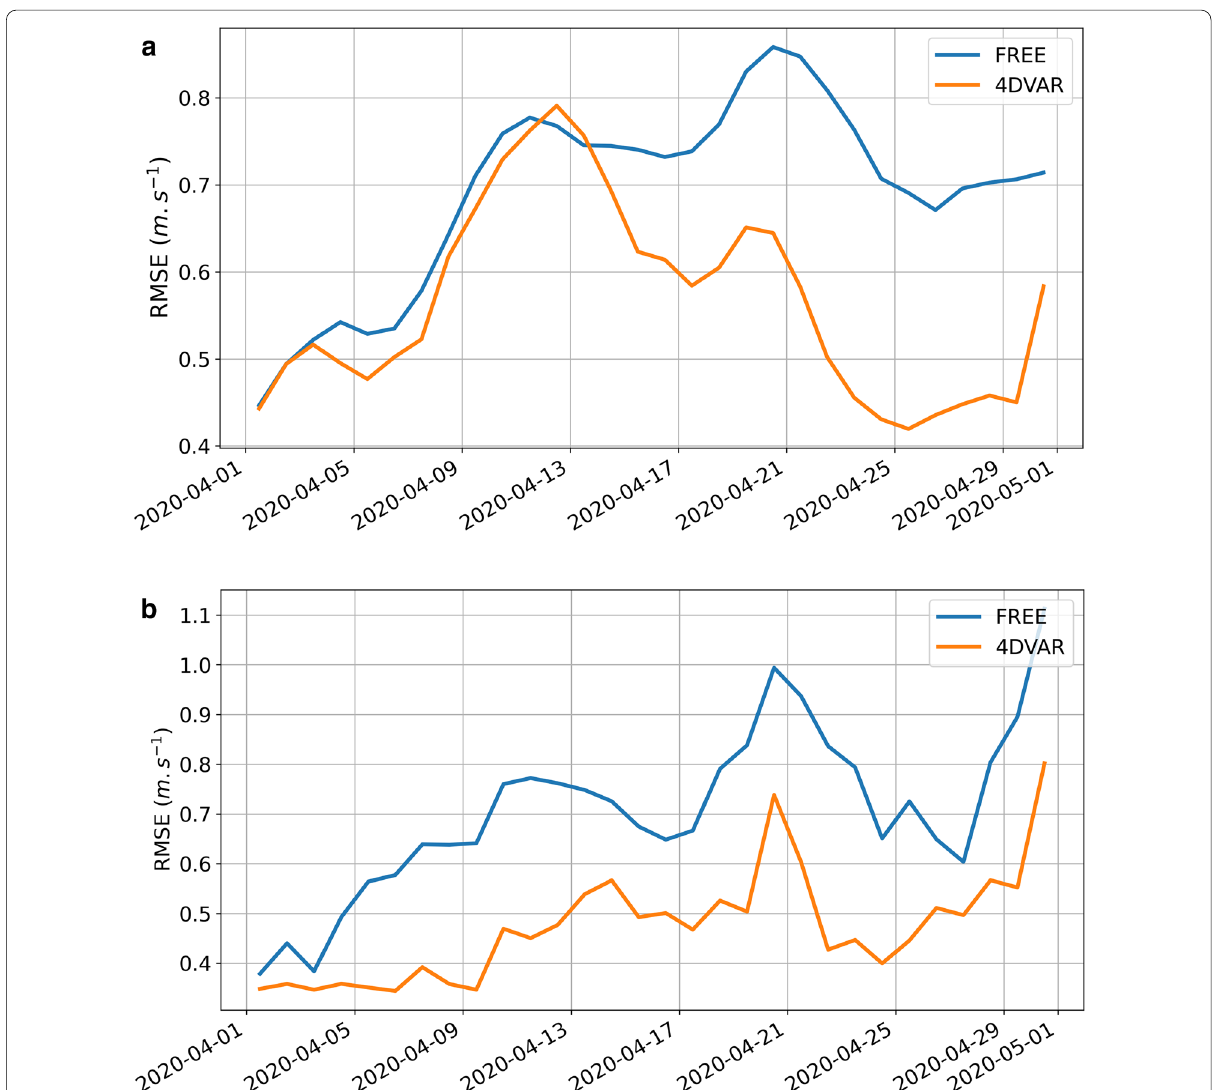
Fig. 4 FREE and 4DVAR geostrophic velocities RMSE (against altimeter derived velocities) for the whole domain ( a ) and over the area of the HF radar observations ( b